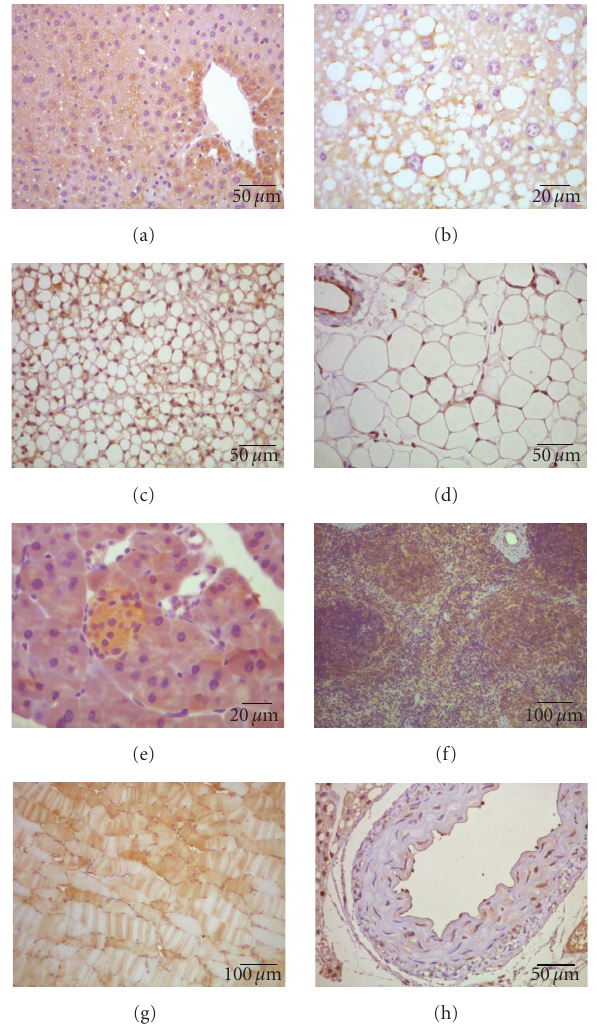
Figure 4: CCL2 is ubiquitously expressed and may be found in multiple cell types. It is easily detected via immunohistochemistry in tissues related to metabolism, including the liver (a), where it is also located in the periphery of lipid droplets (b), brown (c) and white (d) adipose tissues, pancreas (e), spleen (f), muscle (g) and aorta